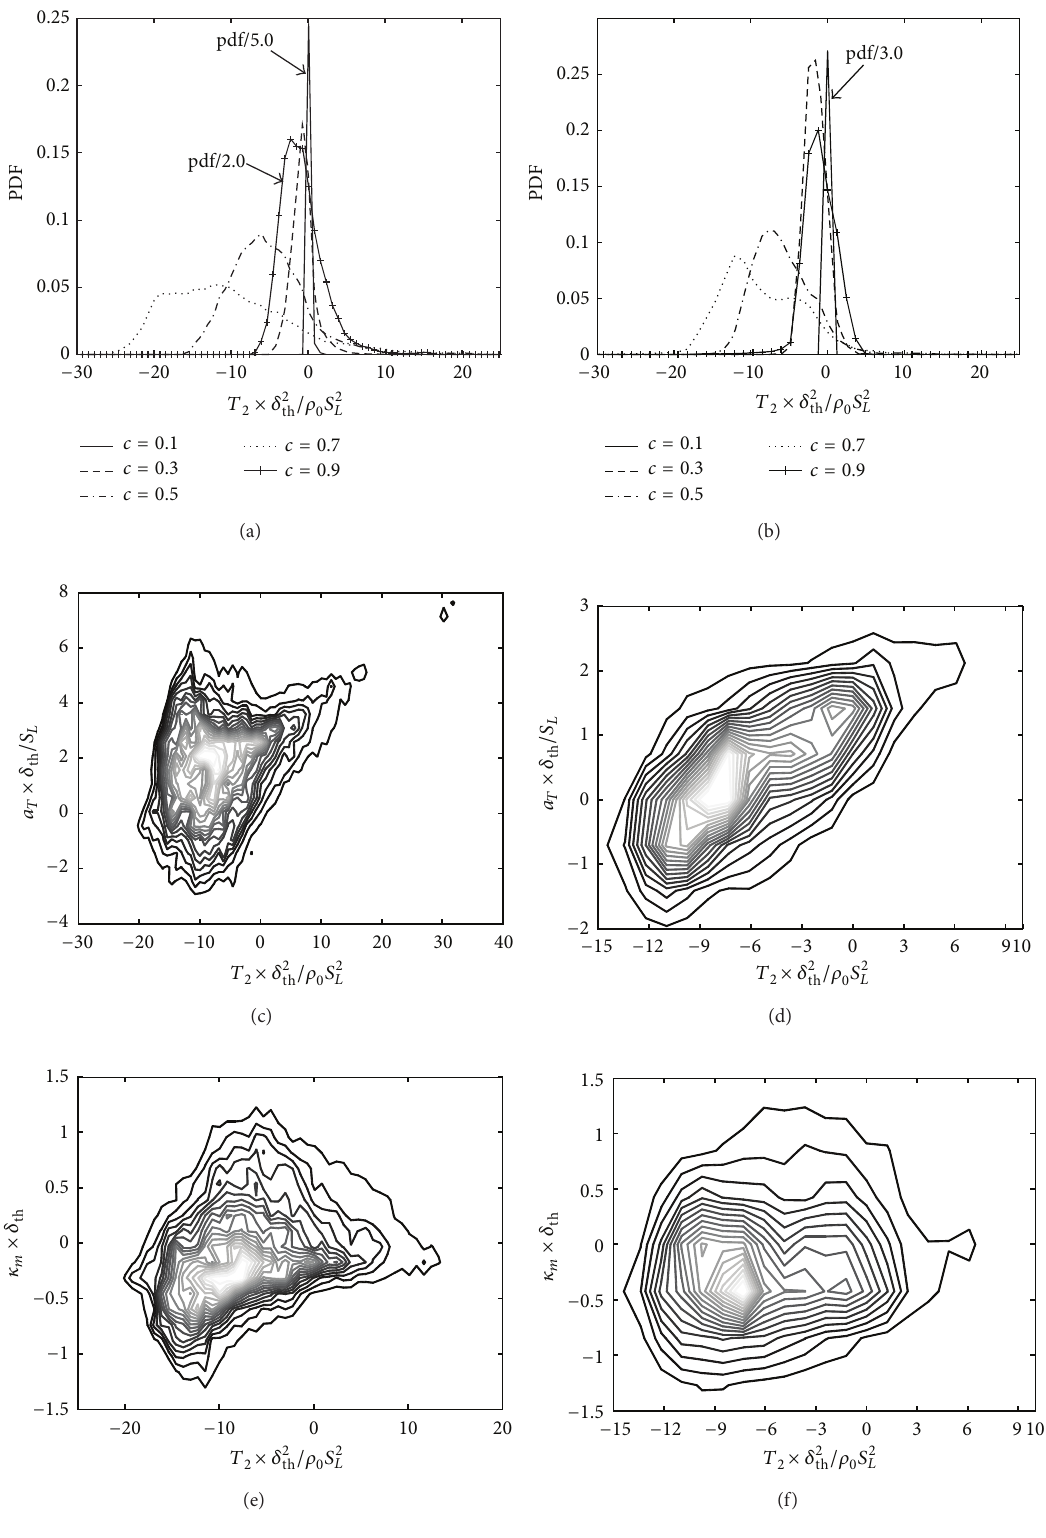
/𝜌 𝑆 2 𝑐 = 0.1 , 0.3, 0.5, 0.7, and 0.9 for cases (a) P3 and (b) V2. Joint pdf between 𝑇 0 𝐿 for th /𝑆 𝑐 = 0.8 isosurface for cases (c) P3 and (d) V2. Joint pdf between 𝑇 𝐿 on th